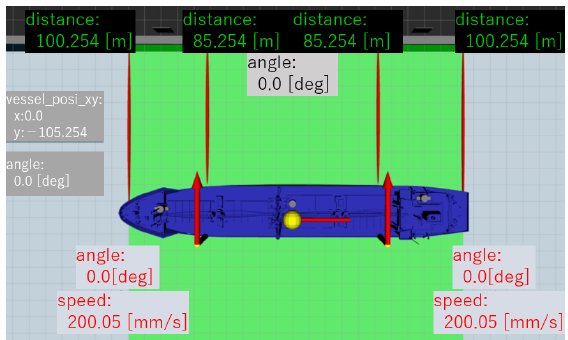
Figure 13. One scene displayed to verify drawing speed.